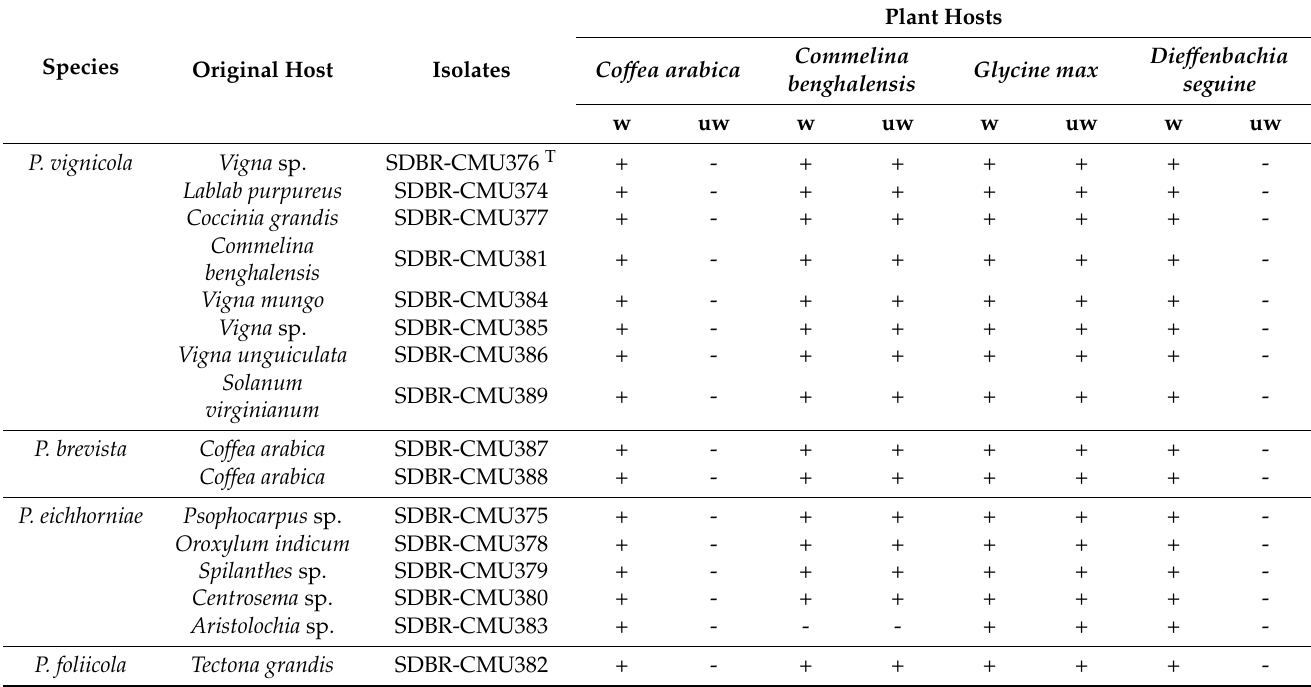
Table 2. Pathogenicity test and cross pathogenicity of Paramyrothecium species on original hosts and other plant